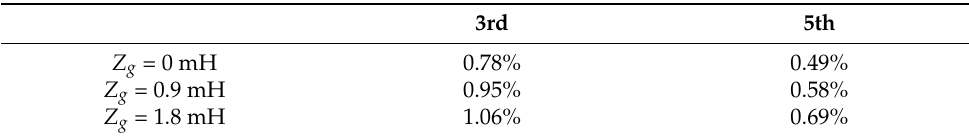
Table 2. 3rd and 5th harmonics in all cases.